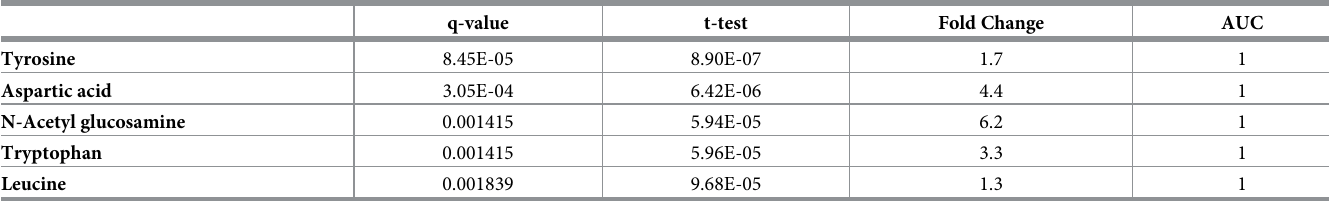
Table 4. Liver metabolites that differed between two species of bigheaded carp (silver carp Hypophthalmichthys molitrix and bighead carp H . nobilis) sampled only from the leading edge of the population in the Illinois River. q-value t-test Fold